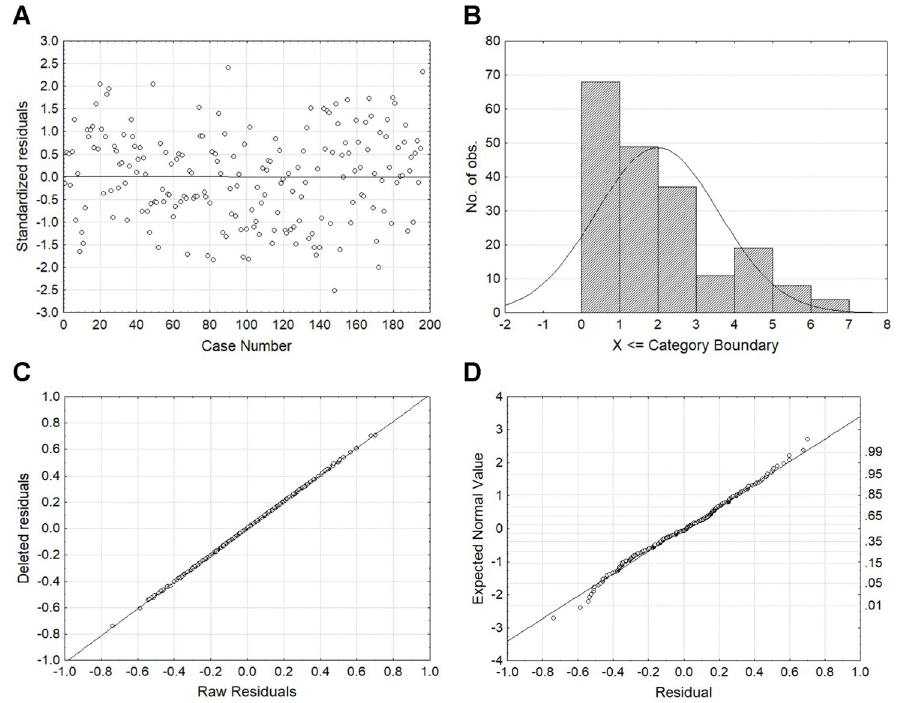
Fig 2. Analysis of regression outliers. Regression plots of (A) standardized residuals as a function of case numbers, (B) Mahalanobis distances, (C) deleted residuals as a function of raw residuals, and (D) expected normal values as a function of residuals, illustrated here in the Number Connection Test part B